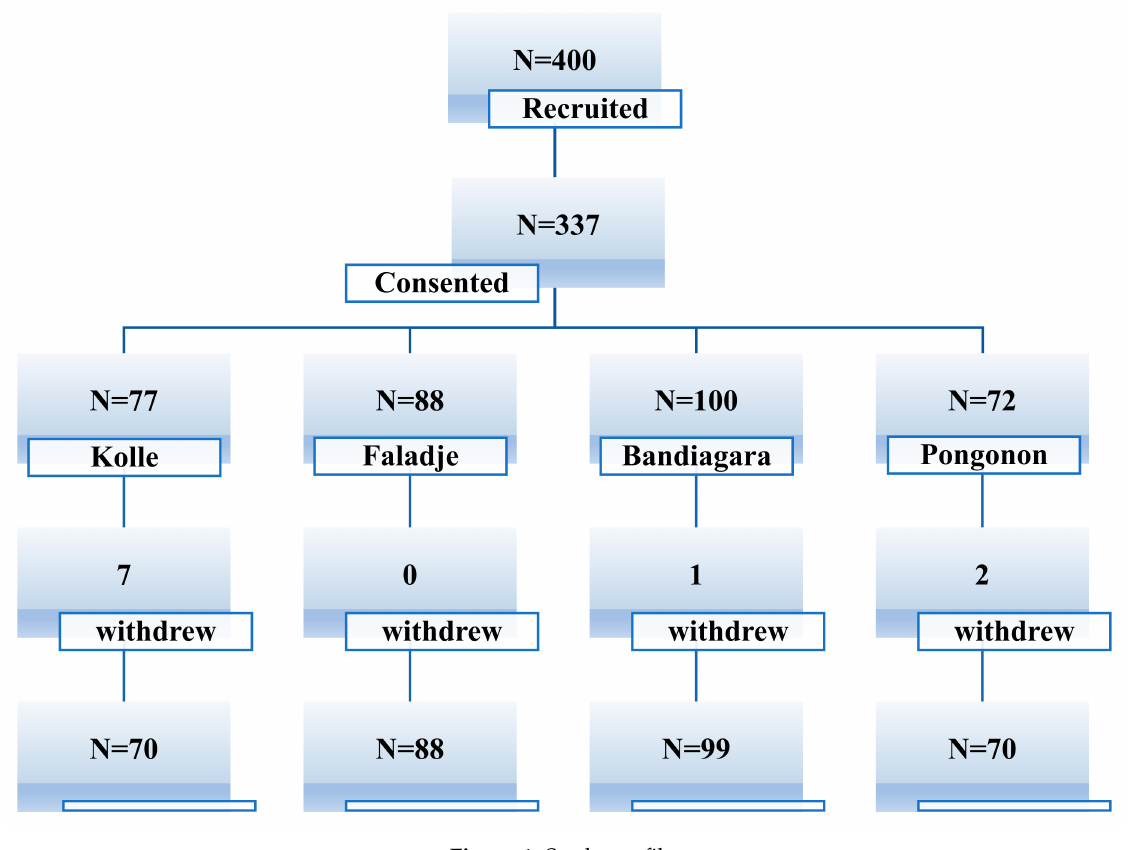
Figure 1. Study profile. Table 1. Sociodemographic, clinical, and parasitological variables at enrollment at each study